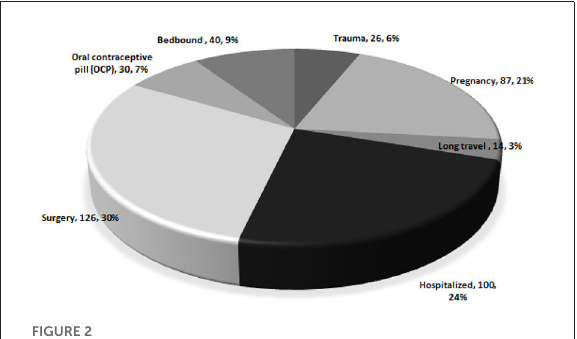
suggest that risk factors for provoked VTE and unprovoked VTE were more common among women, married, obese, those with no history of VTE, no family history of VTE, no hypertension, no diabetes, non-smokers, and with no history of recent hospitalization for a medical condition within the previous 3 months. Additionally, almost none of the patients had peripheral vascular disease, varicose veins, or immobilization of the affected limb. There was a statistically significant association between provoked status and sex, family history of VTE, smoking, underlying peripheral vascular disease or varicose veins, recent hospitalization within 3 months for a medical condition, and the site of VTE ( p < 0.05). The median age of the patients at diagnosis was somewhat comparable between the two groups (provoked vs. unprovoked VTE, p = 0.235). In each patient group, the most common VTE event was deep vein thrombosis (DVT) alone, with the highest percentage of DVT events occurring in patients with provoking factors (69.7%) (Table 2). Figure 2 shows the distribution of the causes of provoked VTE. The most common causes of death were surgery ( n = 126, 29.8%), hospitalization ( n = 100, 24.2%), and pregnancy ( n = 87, 20.6%). Other causes were also reported, including being